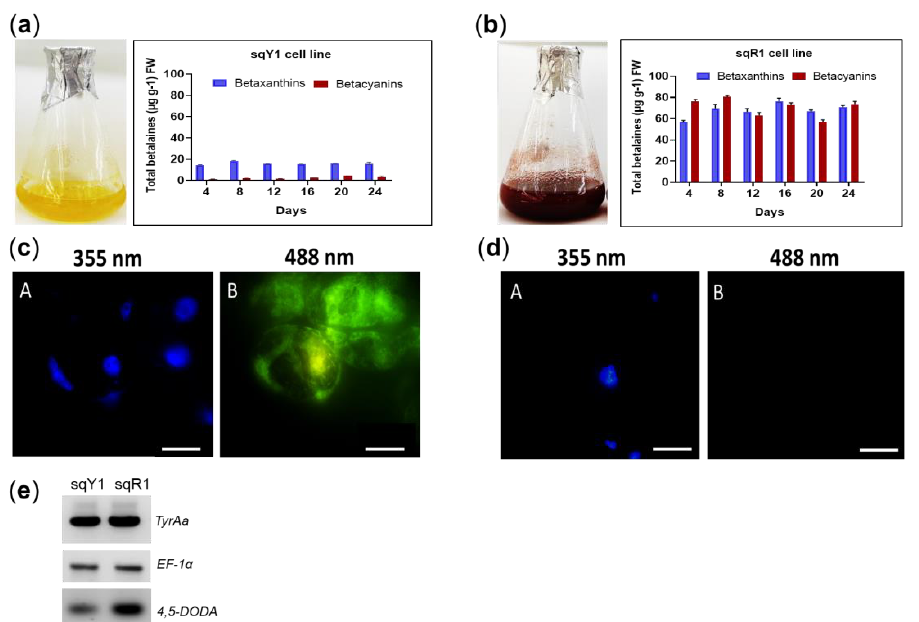
Figure 1. Pigments quantification and microscopic characterization of S. queretaroensis cell suspen- sions. ( a ) Pigments quantification on sqY1 line (yellow). ( b ) Pigments quantification on sqR1 line (red). The bar indicates a standard error of three independent replicates as described in material and methods. ( c : A, B) Cells stained with DAPI at 355 nm and autofluorescence at 488 nm on sqY1 line. ( d : A, B) Cells stained with DAPI at 355 nm and no autofluorescence at 488 nm on sqY1 line. Bar scale 10 µ m with three independent replicates. ( e ) RT-PCR of TyrAa, DODA and EF-1 α from sqY1 and sqR1 cells.